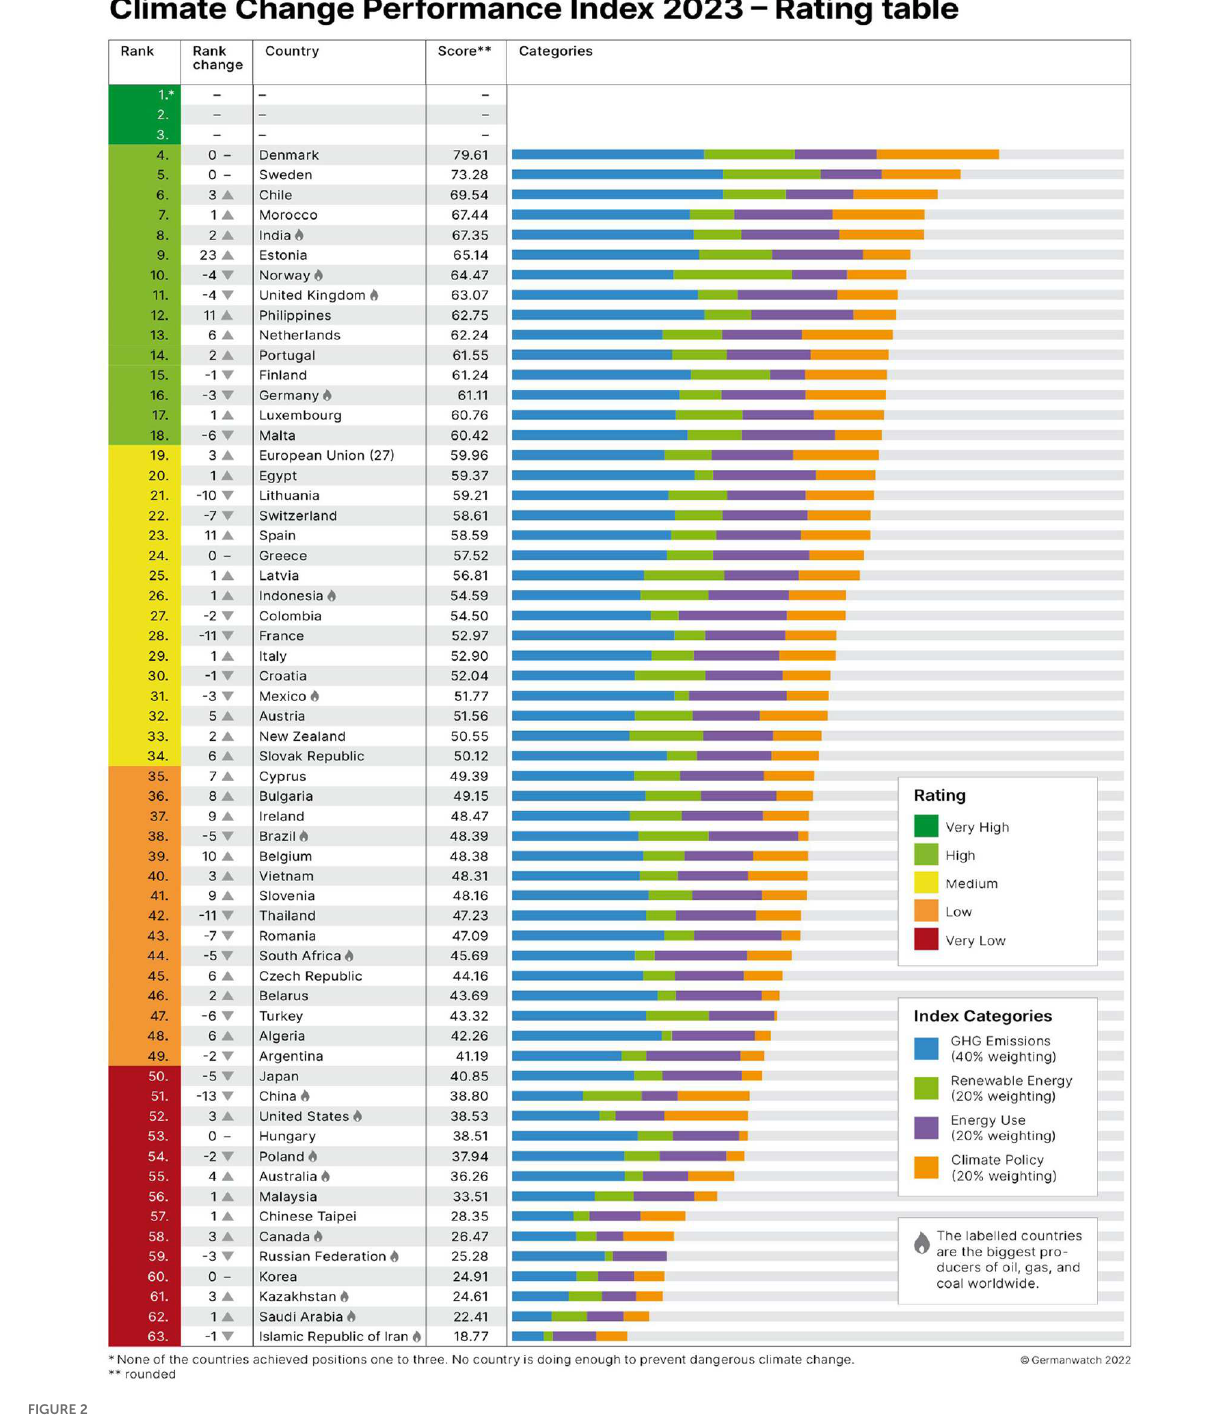
FIGURE2 CCPI ranking